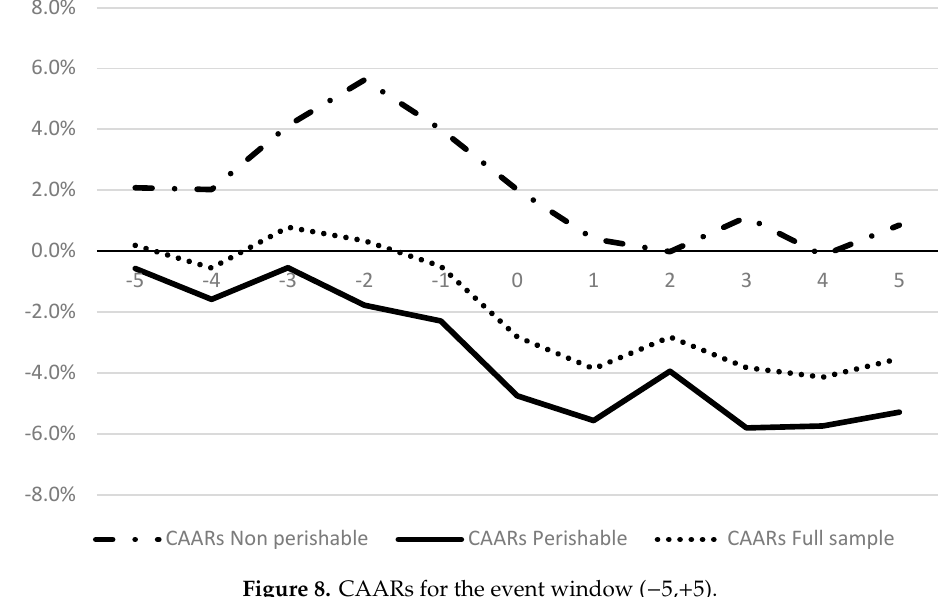
Figure 8. CAARs for the event window ( − 5,+5).